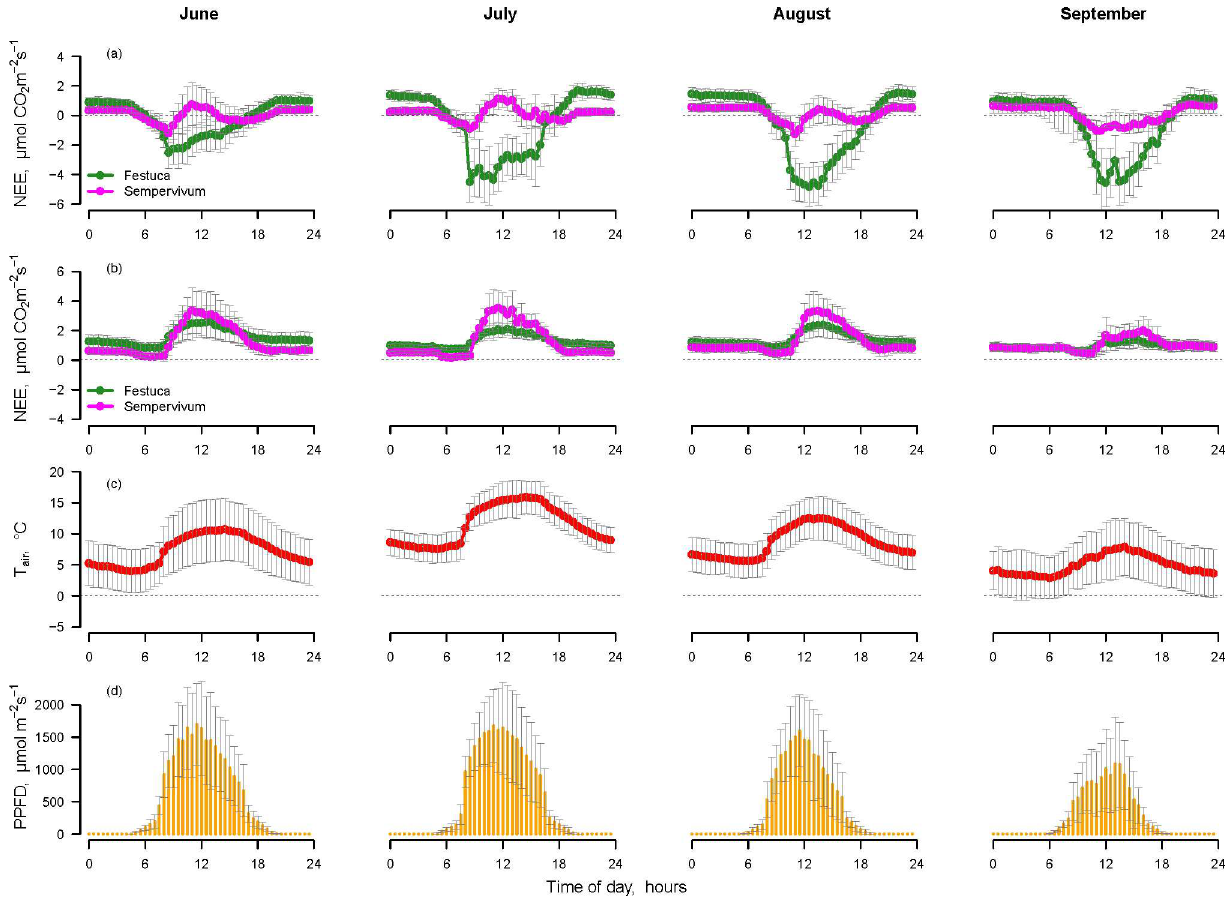
Fig 6. Daily pattern of net ecosystem exchange (NEE) measuredwith (a) transparent chambers, (b) opaque chambers. Panels (c) and (d) show the diurnal pattern of air temperatureand photosynthetic active photon flux density (PPFD). Data are presentedas monthly averages ± SD in June, July, August, and September